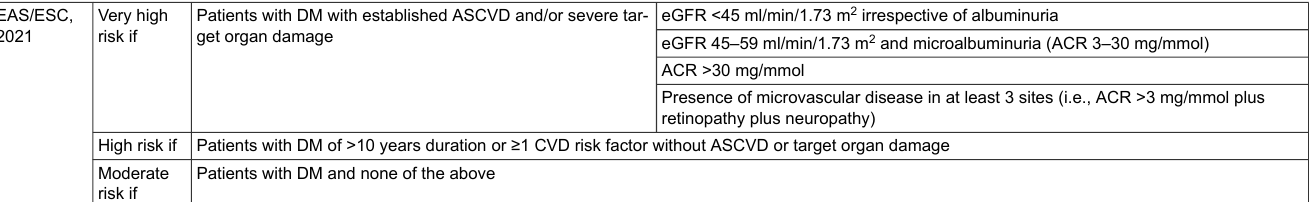
Table 5: Current recommendations on cardiovascular risk stratification in diabetes and chronic kidney disease [51, 58]. EAS/ESC, Very high Patients with DM with established ASCVD and/or severe tar- 2021 risk if get organ